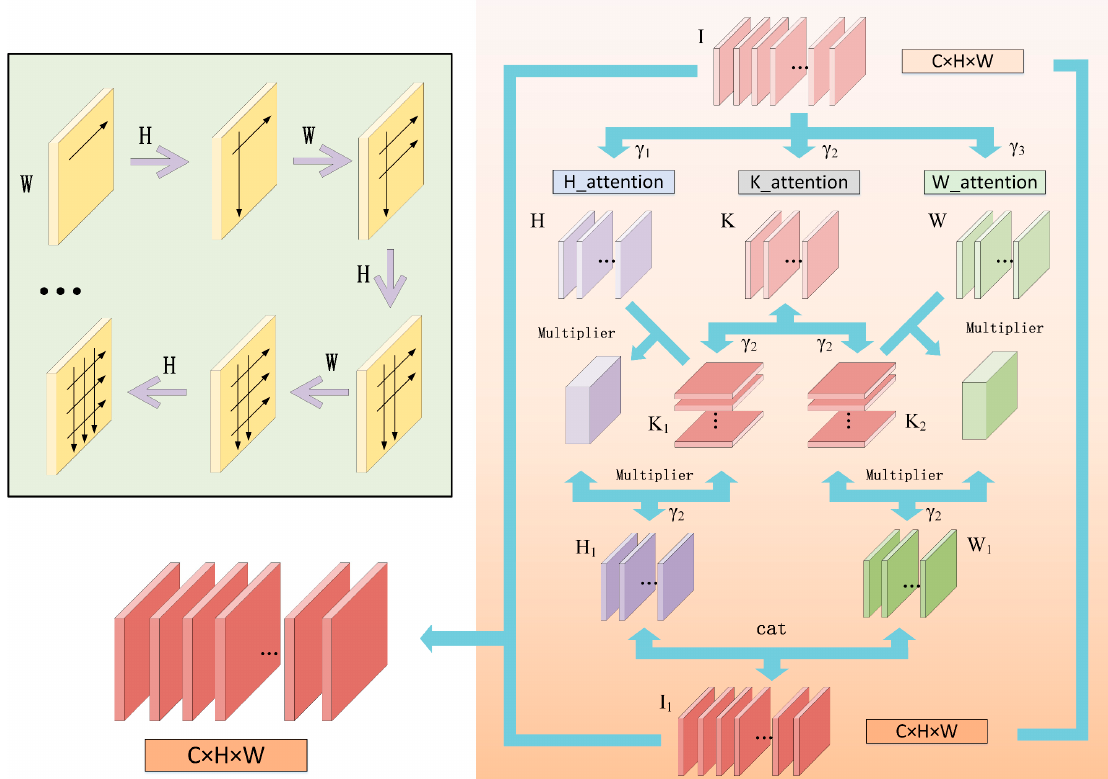
Figure 4. Our Multi-Cross attention module. We extracted features deeply in horizontal and vertical direction multi-cross. We set the “H_attention” as the vertical direction, the “W_attention” as the horizontal direction, and the “K_attention” as the auxiliary branch. The input eigenvector has height H, width W, and the number of channels C. With the gradual enrichment of cross operations, the feature extraction is strengthened fully, and the superiority of attention weight is gradually embodied. Finally, an efficient attention module is constructed with several multipliers and fusion operations in horizontal and vertical directions. This process is illustrated in the upper left block diagram. The final output is the same size as the input.